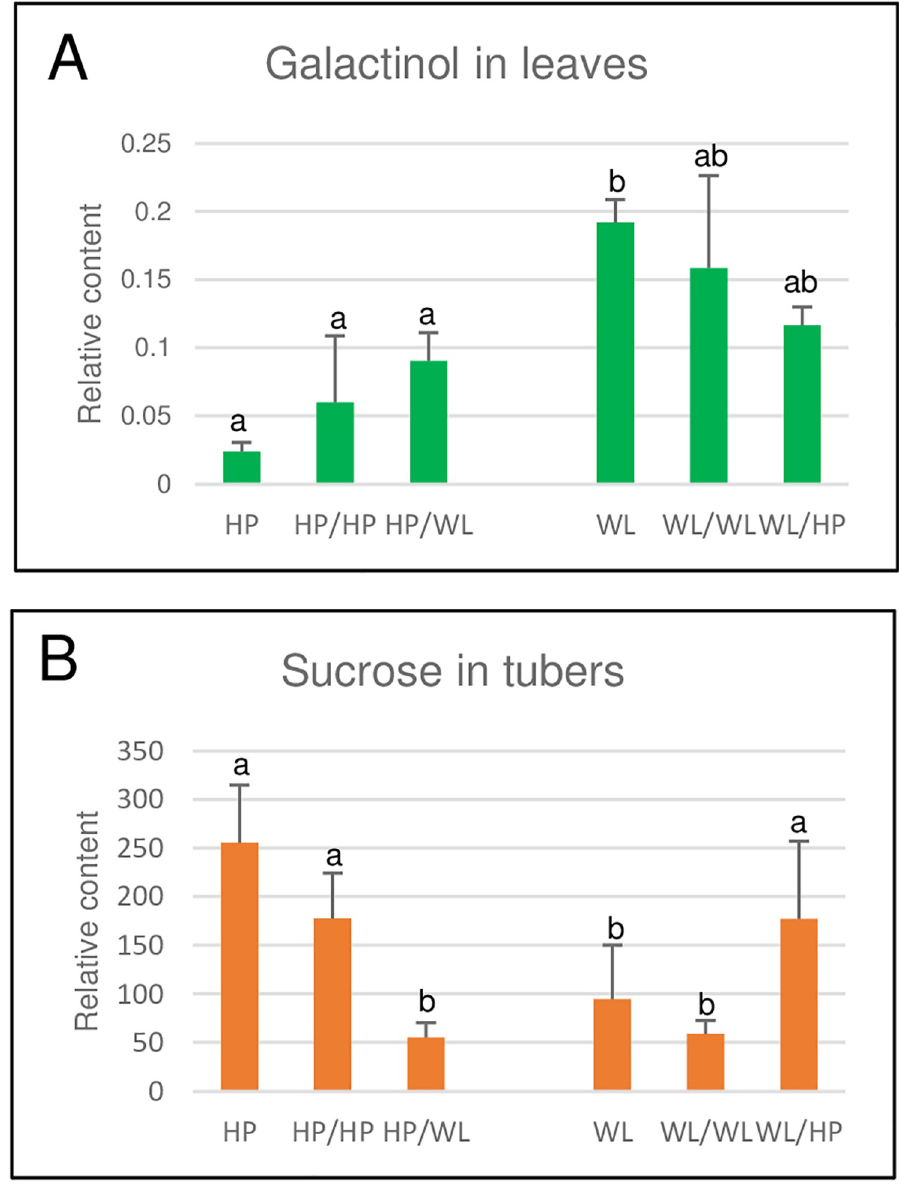
Fig 5. Differences in the galactinol and sucrose contents of leaves and tubers, respectively, detected by GC-MS; the relative data shown on the y axis are derived from a comparison of the peak sizes of the samples and an internal standard, ribitol. The means were obtained from the data presented in S1 and S2 Tables. The standard deviations are indicated by the error bars. The means presented with the same letter are not significantly different at p � 0.05 calculated by one-way ANOVA with post hoc Tukey HSD test. The labels of the x axis are as in Fig